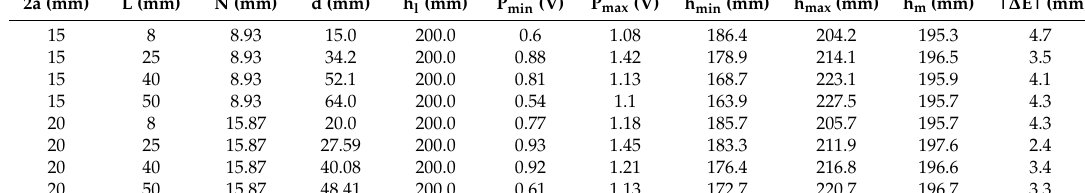
Table 3. Result of liquid level test.